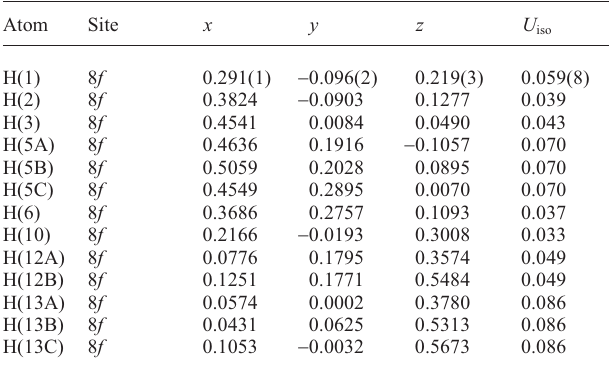
Table 1. Data collection and handling.